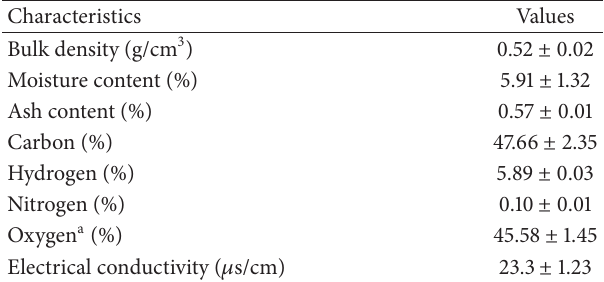
Table 1: Characteristics of wood apple shell (WAS) biosorbent.